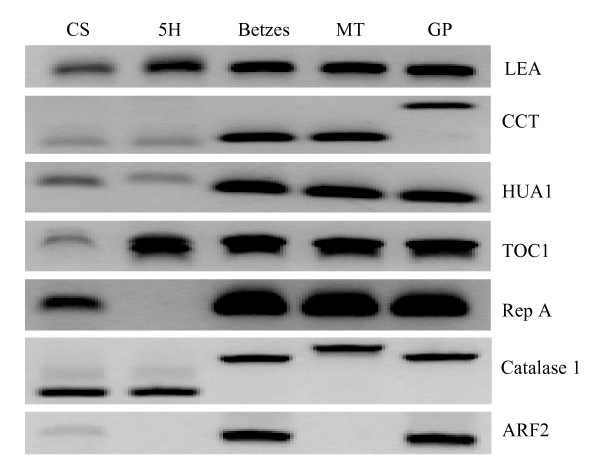
Differentially expressed genes and 5H wheat-barley addition line. Some of the differentially expressed genes were checked for map position on chromosome 5H of barley (Ari-e locus is on 5H). Wheat background genotype used is Chinese Spring (CS), the barley genotype Betzes, and the addition line is 5H. None of the genes identified by array analysis (LEA, CCT motif protein, HUA1, Replication protein A, catalase1, and ARF2) mapped to 5H. A gene which maps to 5H (e.g. Timing of CAB expression 1, TOC1) is expected to have a stronger band in 5H relative to CS. Three genes CCT, catalase 1 and ARF2 have different alleles in Maythorpe (MT) and Golden Promise (GP).